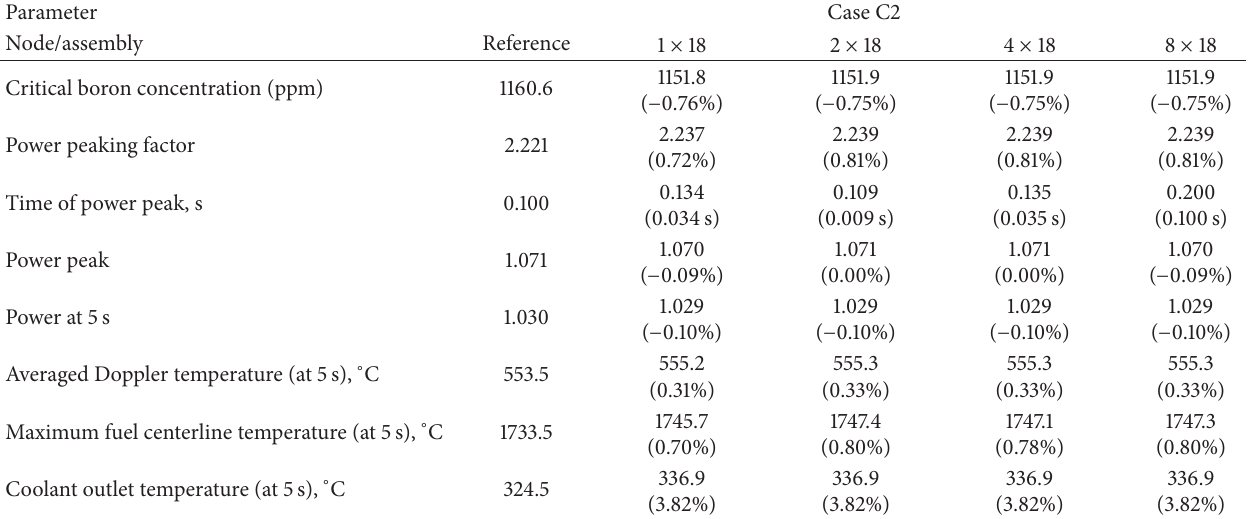
Table 6: Sensitivity analysis results in the axial node number per assembly for case C2.